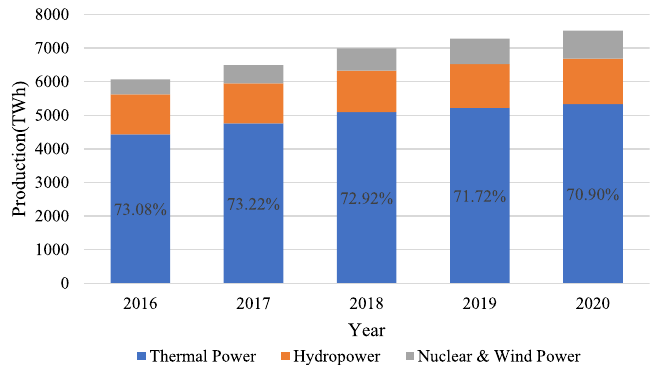
Figure 1. The structure of electricity production in